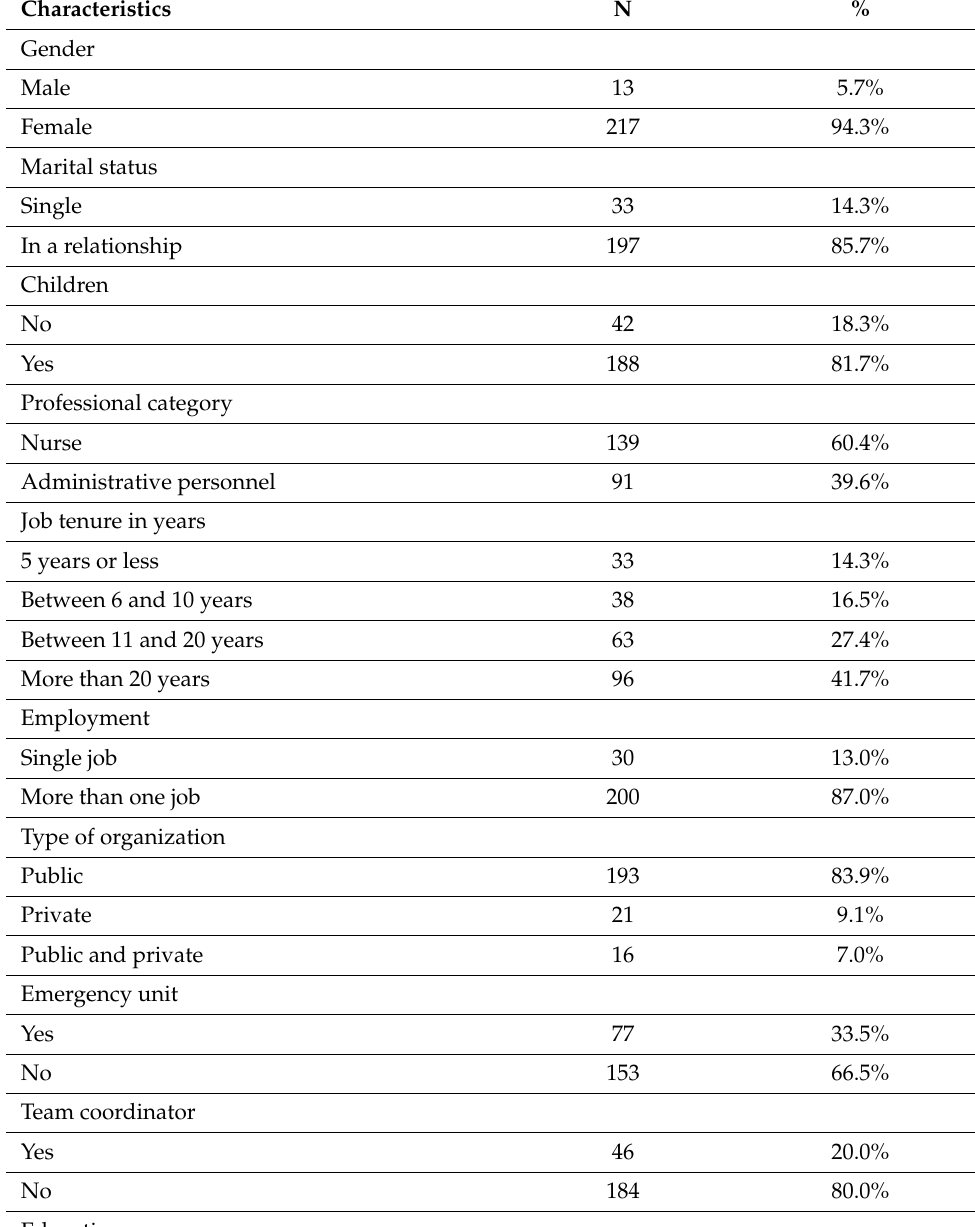
Table 1. Characteristics of the study sample ( n =